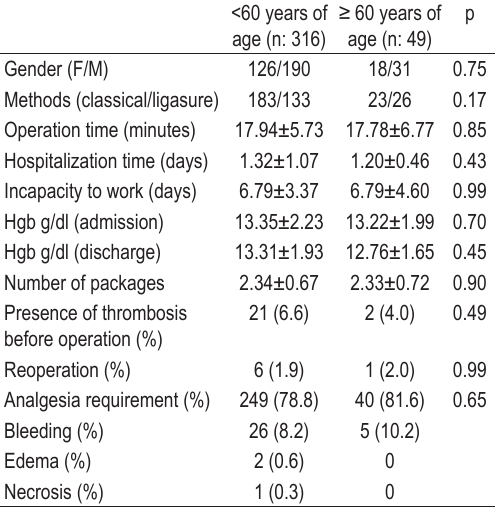
TABLE 1. General characteristics and outcomes of the hemorrhoid operations among the different age